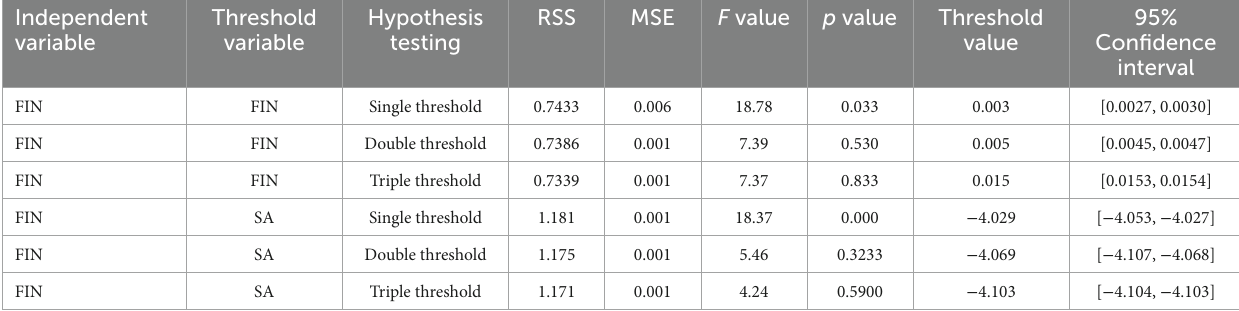
TABLE 10 Threshold effect test results.